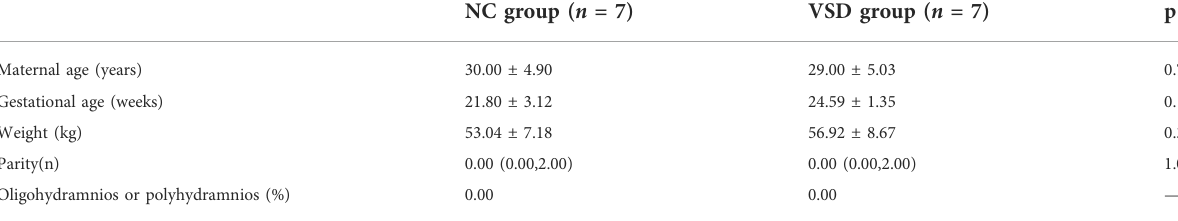
TABLE 1 General characteristics of pregnant